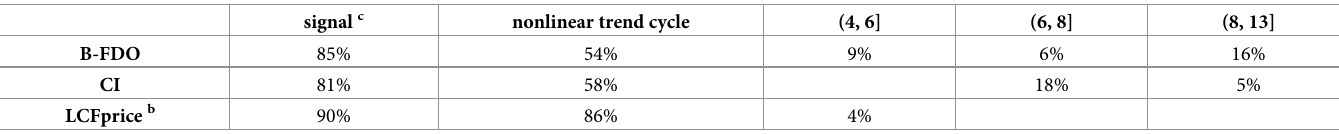
Table 1. Signal processing with singular spectrum analysis a